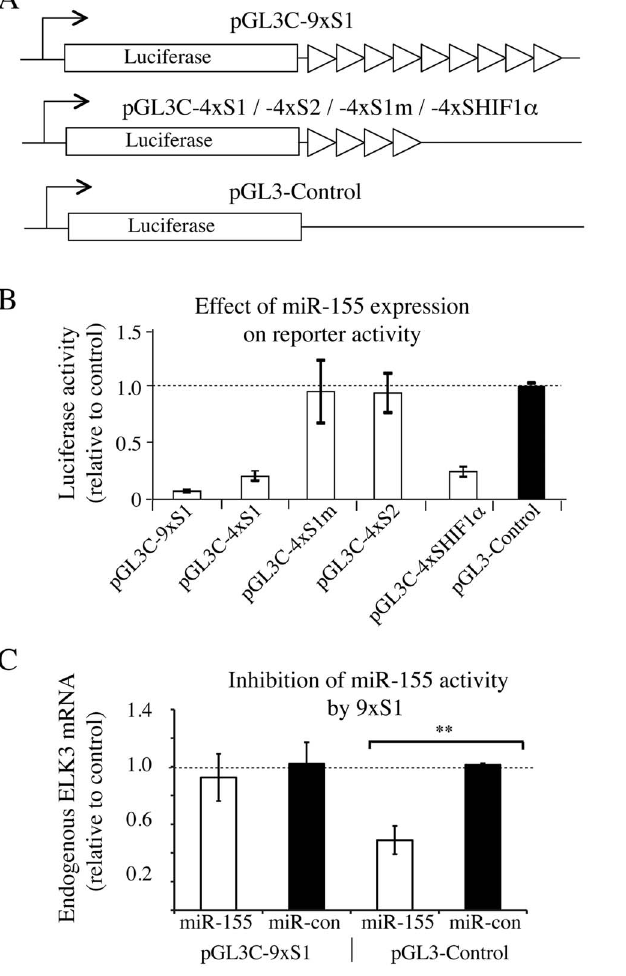
Figure 4. Activities of multimerised ELK3 target sites. (A) Schematic representations of the region of pGL3-Control that contains luciferase coding sequences, the initiation site of the SV40-early promoter and the site of insertion of 4 or 9 copies of S1, S2, S1 mut (S1m) or HIF1 a target sequences (Bruning et al ,) [20]. (B) Effect of miR- 155 mimic expression on luciferase expression from the indicated reporters, normalised to the control vector. The error bars represent the S.D. between two separate transfection experiments. (C) Block of miR- 155 inhibition of endogenous ELK3 mRNA by overexpression of ELK3 S1 (site 1 miR-155 target sequence). miR-155 mimic or miR control were cotransfected with either the empty control vector or pGL3C-9xS1. Two independent transfection experiments, each analysed twice by qPCR, as described in the Methods section. **p , 0.01, error bars represent S.D.).